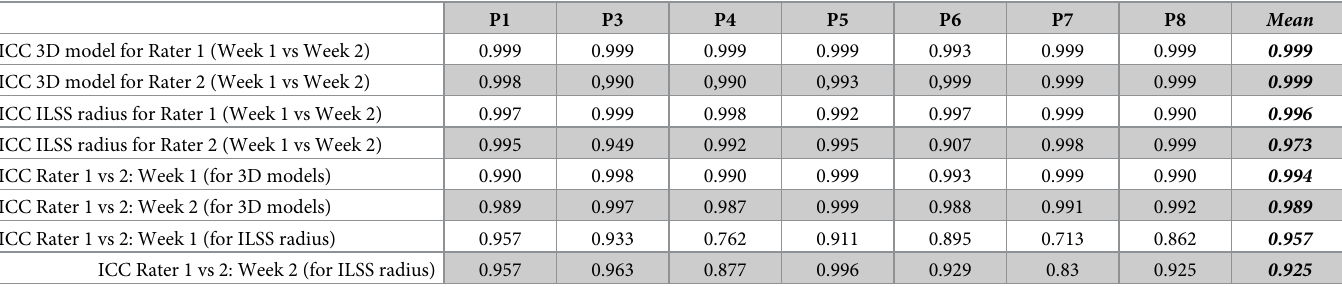
Table 2. Intra- and inter-rater agreement.